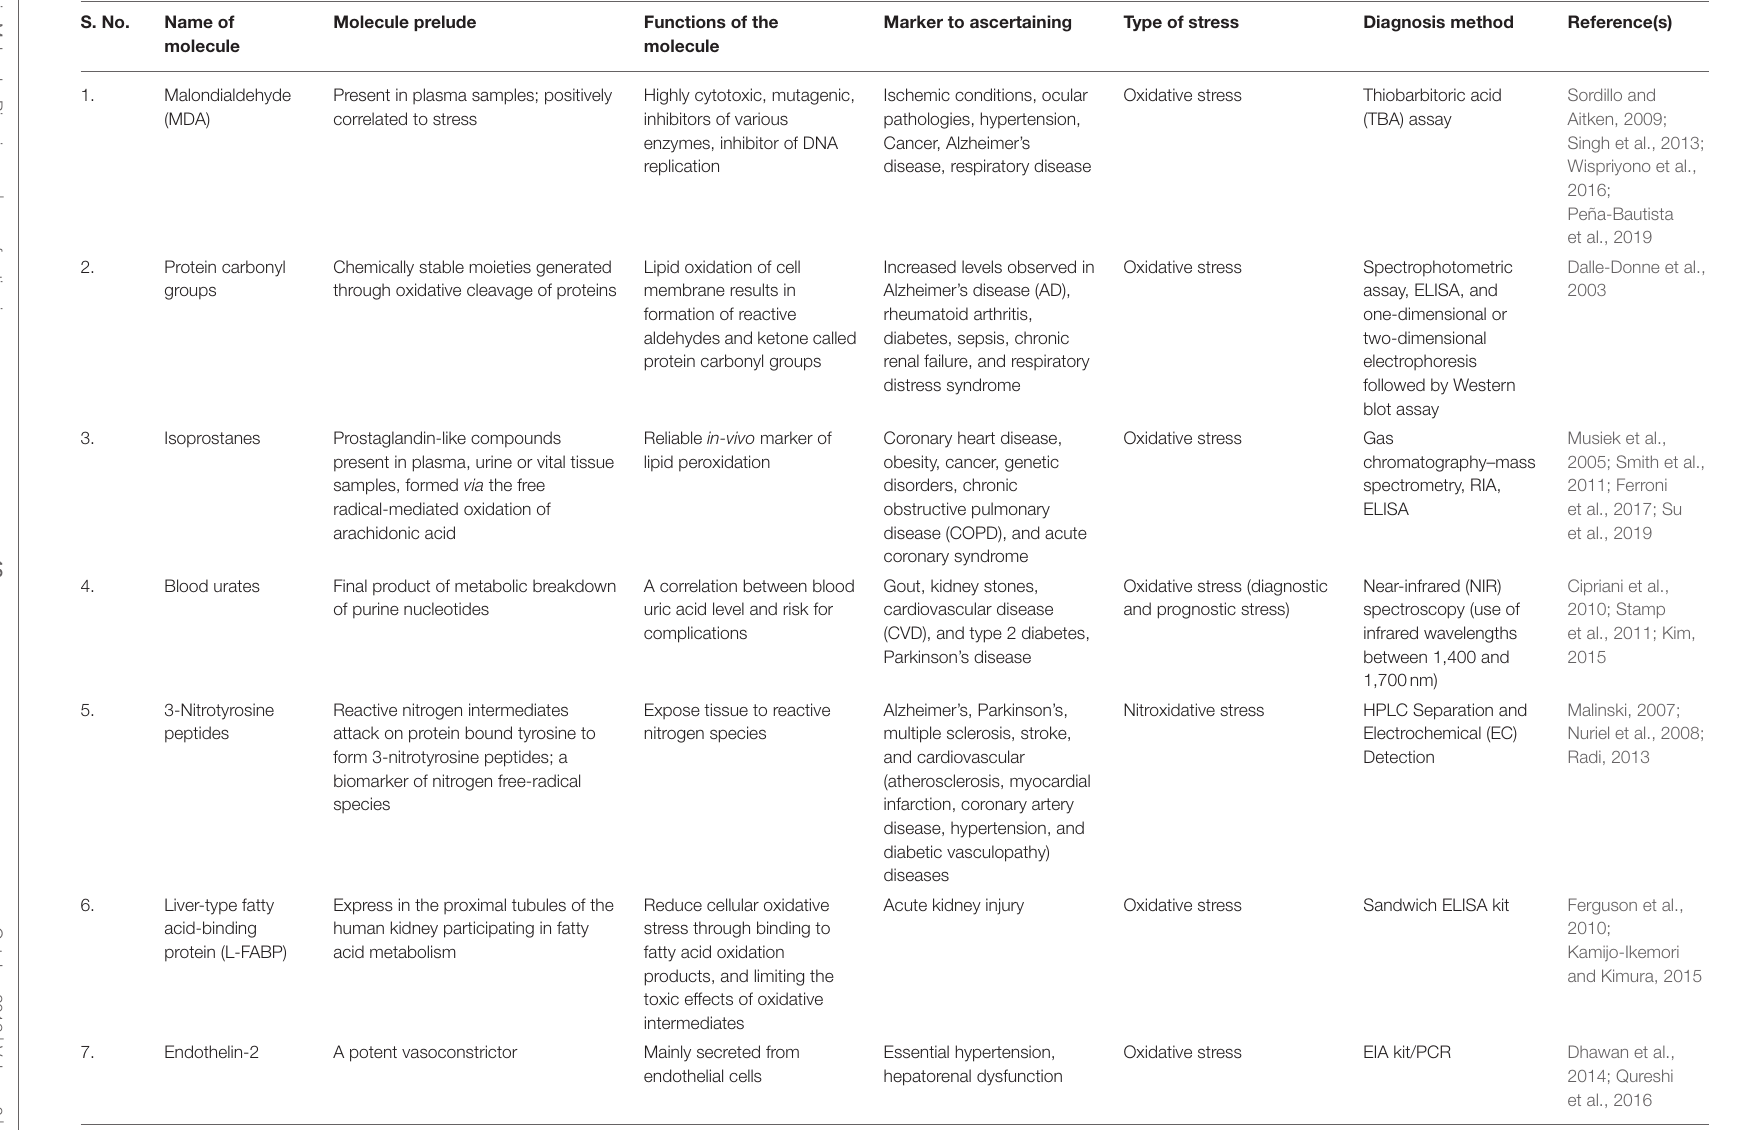
TABLE 1 | Biotic stress markers, the associated ailments and their detection methods. S.